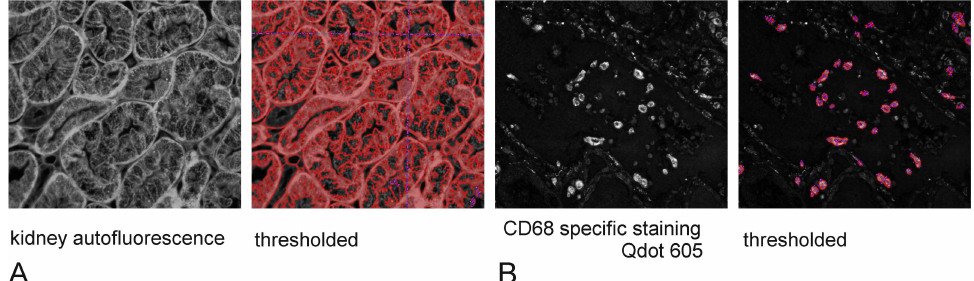
Fig 6. Autofluorescenceand specificfluorescence thresholdfor quantification. Intensityimagesof FFPE kidney sections, unstained (autofluorescence) or stainedwith for CD68 using specific Ab and secondary conjugated with Qdot were quantifiedat the peak of fluorescence using Nuance software. This was performed for each Qdot,illuminated by each light source. The figureshows the example of the emissionat 605nm for a slide labelledwith Qdot 605 and an unstainedsection fromthe same tissue (autofluorescence)illuminated by LED4000435nm.A: Intensityimageof kidney tubules autofluorescence at 605nm,and corresponding thresholdedareasfor quantification of the autofluorescence intensity. B: Intensityimageof a serialsection labelledwith Qdot605 at 605nm and thresholded image for quantification (minimum100 pixels